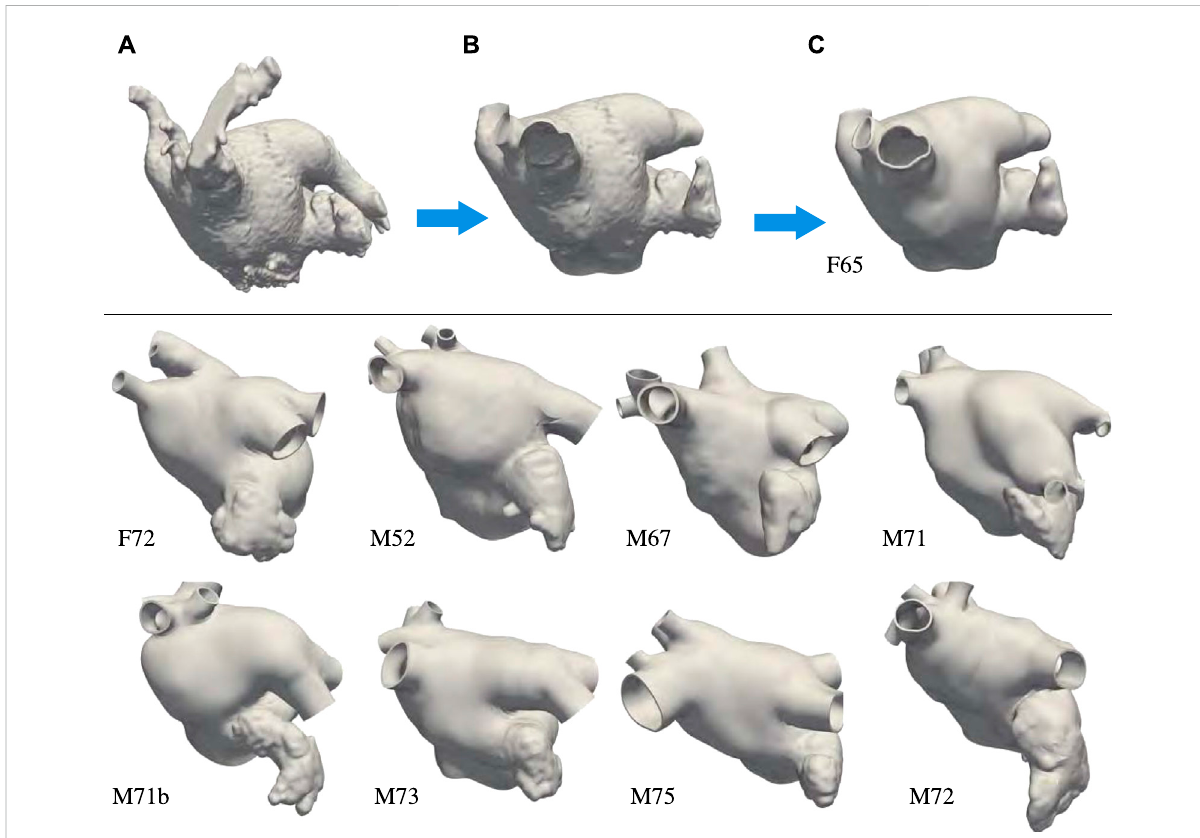
FIGURE 1 Top: Preprocessing steps: (A) Segmentation extracted from the patient computed tomography images. (B) Preprocessing of the endocardial surface after chopping the pulmonary veins opens and opening the mitral valve ring. (C) Thickened and retopologized atrial surface. Bottom: fi nal preprocessed left atrial surfaces of eight patients who underwent WATCHMAN device implantation. We remark that most of these patients have accessory right pulmonary veins and two of them a common left pulmonary trunk. We label the anatomies using F and M, to indicate patients ’ gender, followed by their